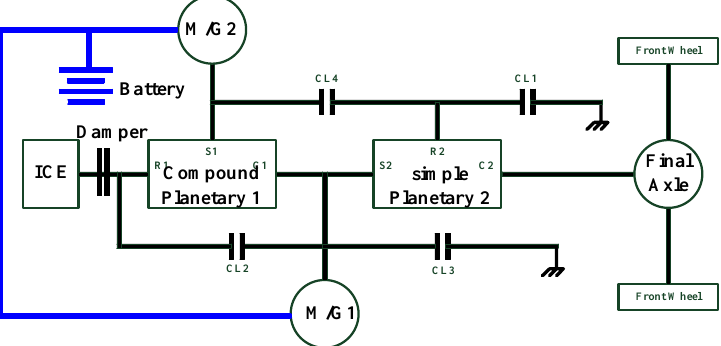
Figure 4. Driveline configuration of two-mode hybrid power system.